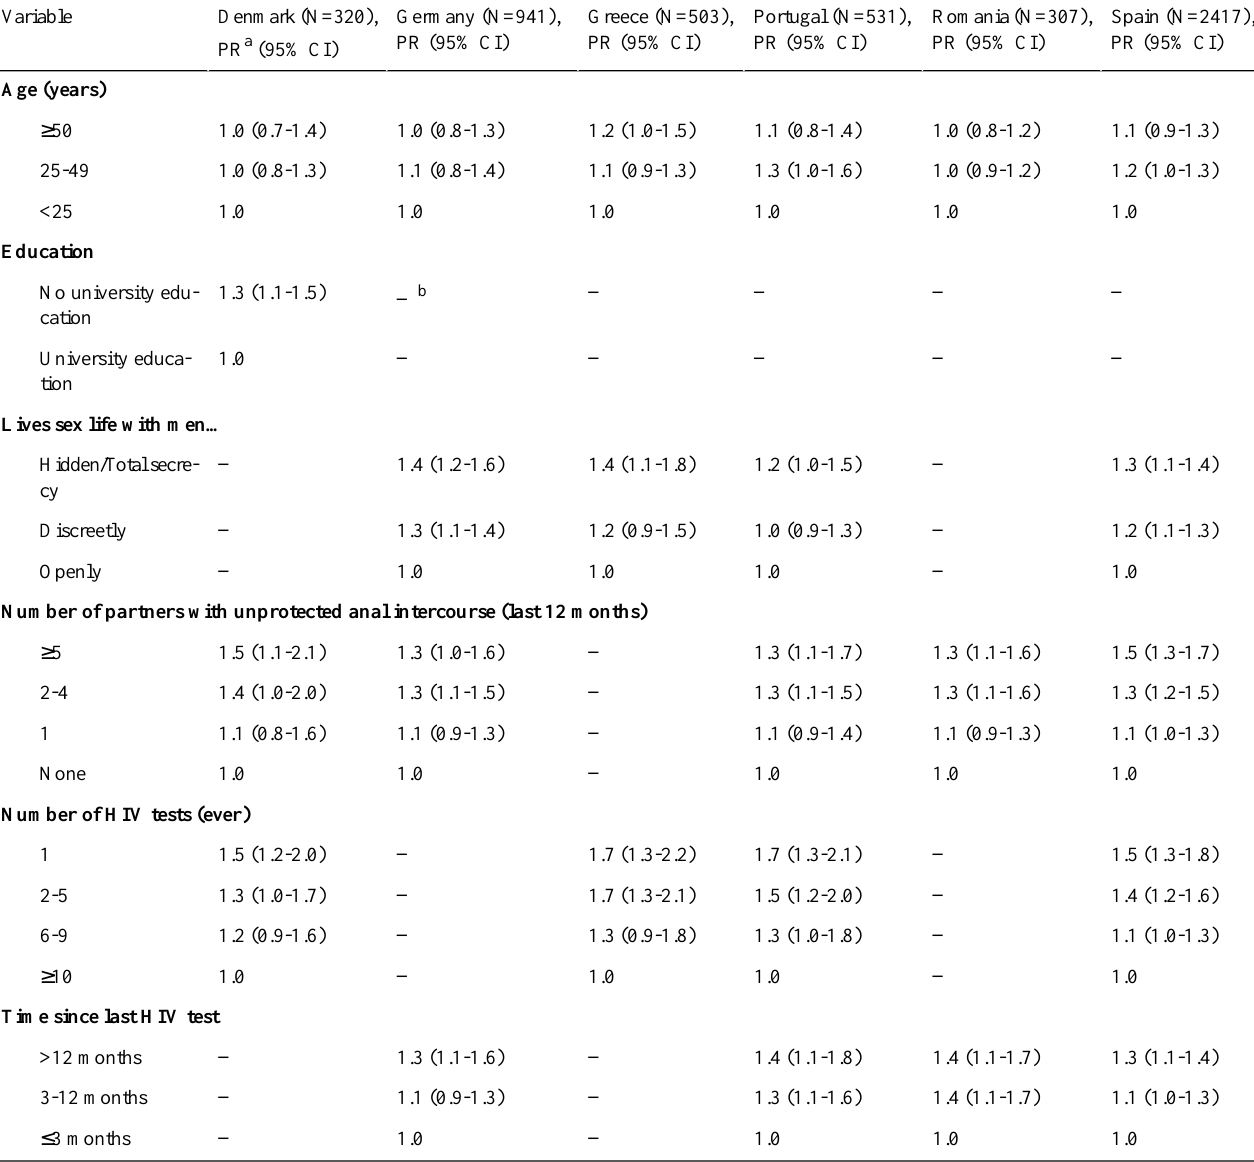
Table 2. Factors associated with a potential increase of testing frequency if self-sampling was made available.